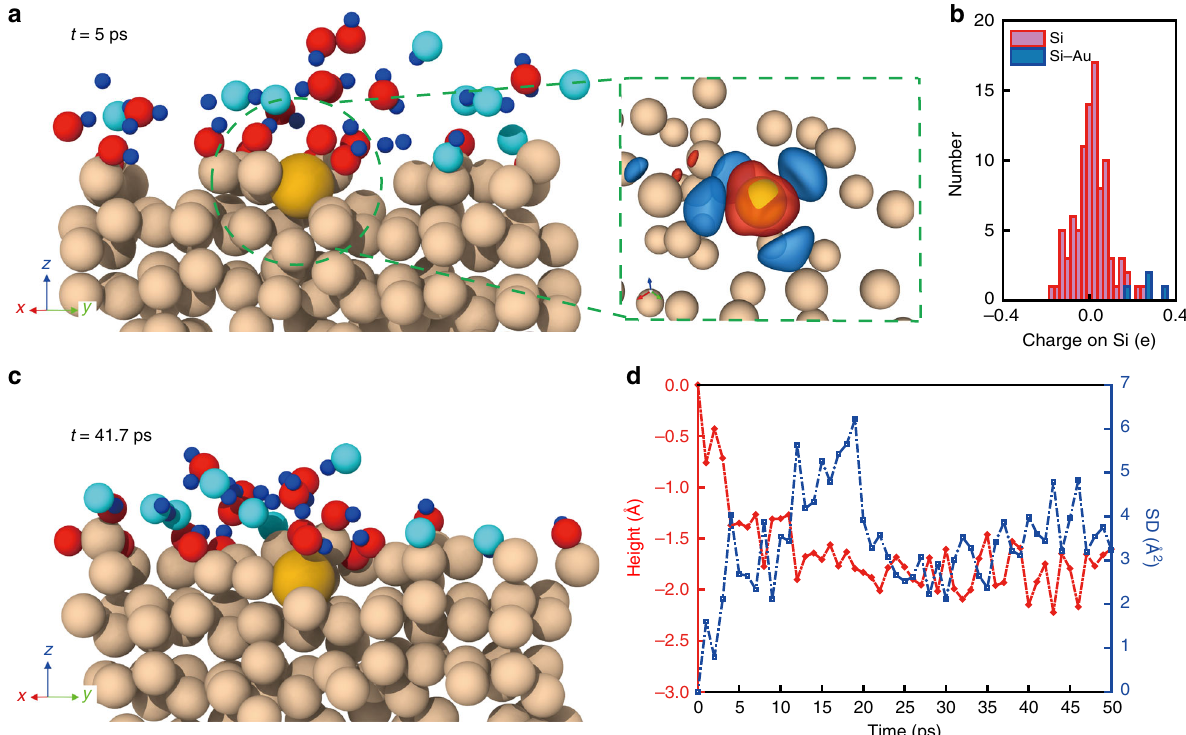
Fig. 3 Ab initio molecular dynamics simulation of the catalytic effect of atomic Au. a A representative AIMD snapshot (left) and the corresponding charge transfer between Au and Si atoms (right) at t = 5 ps. Atoms are represented as almond (Si), yellow (Au), red (O), cyan (F), and blue (H) spheres. Isosurfaces represent volumes where electron density decreases (blue) and increases (red) due to the in fl uence of the Au atom. b A histogram showing the distribution of charges on Si atoms bonded to Au (blue) and faraway bulk Si (red) atoms. Si atoms bonded to Au have the highest positive charges. c An AIMD snapshot sampled at a later time point, i.e., t = 41.7 ps. In both sampled con fi gurations, the fi rst nearest-neighbor Si atoms lose electrons to the more electronegative Au atom. This increase in electropositivity of adjacent Si atoms translates to higher reactivity in the presence of electron-rich